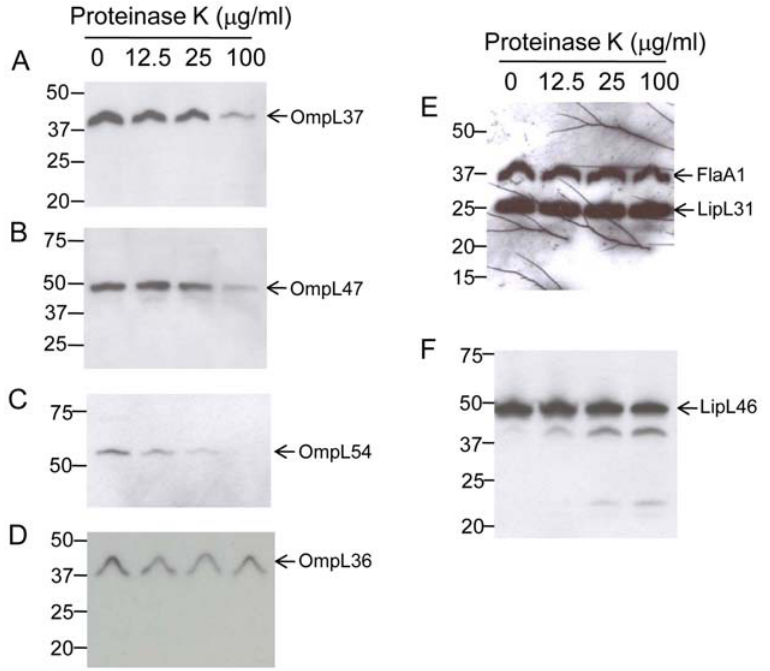
Figure 2. Surface localization of L.interrogans serovar Copenhageni strain Fiocruz L1–130 proteins by proteinase K treatment. Whole intact spirochetes were incubated with different concentrations of proteinase K, equivalents of 1 6 10 8 of leptospires per lane separated by gel electrophoresis (Bis-Tris 4–12% NuPage gel, Novex), transferred to a PVDF membrane, and probed with polyclonal rabbit antisera against: (A) OmpL37; (B) OmpL47; (C) OmpL54; (D) OmpL36; (E) FlaA1 and LipL31; (F) LipL46. The identities of individual proteins are indicated on the right, and the positions of molecular mass standard (in kilodaltons) are indicated on the left.